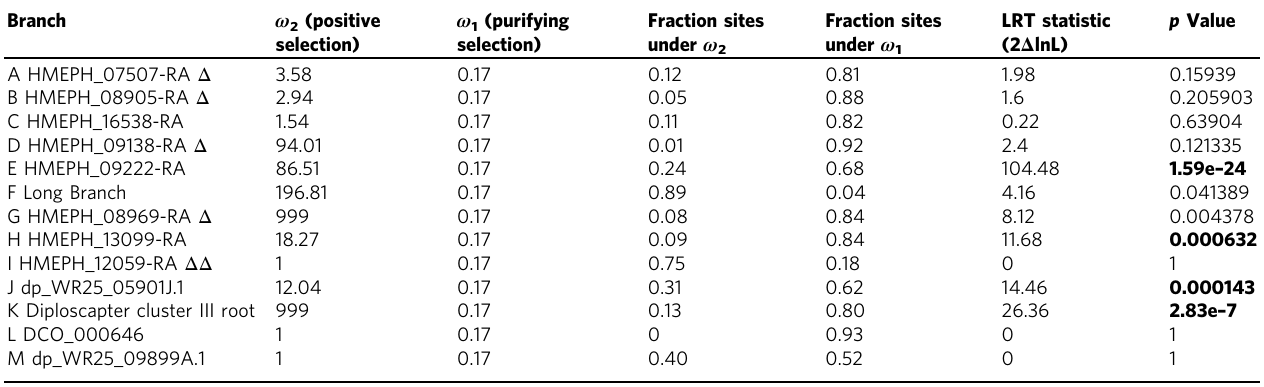
Table 3 Branch-site analysis of dN/dS ratios ( ω ) from tree in Fig. 2b